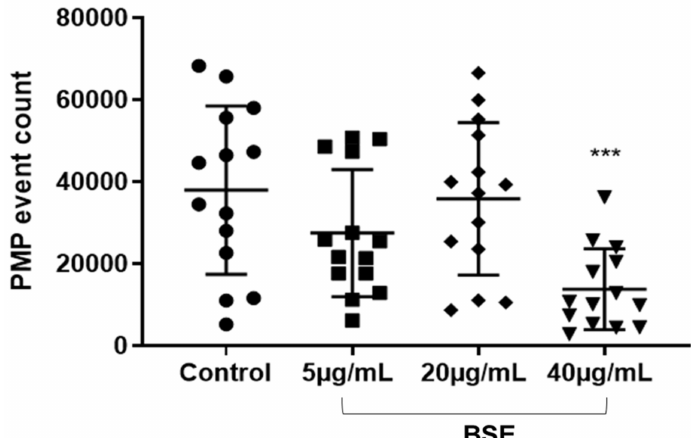
Figure 2. The e ff ect of varying concentrations of BSE on circulatory PMP production in vitro. BSE at 40 µ g / mL significantly reduced the amount of circulatory PMPs ( < 24190 ± 4935, p = 0.0008). BSE at 5 µ g / mL and 20 µ g / mL did not reduce platelet aggregation when compared to control ( p value > 0.1). N = 14 and data are represented in number of PMP events versus BSE concentrations. *** signifies statistical significance p < 0.001 compared to control. Error bars expressed as mean ±